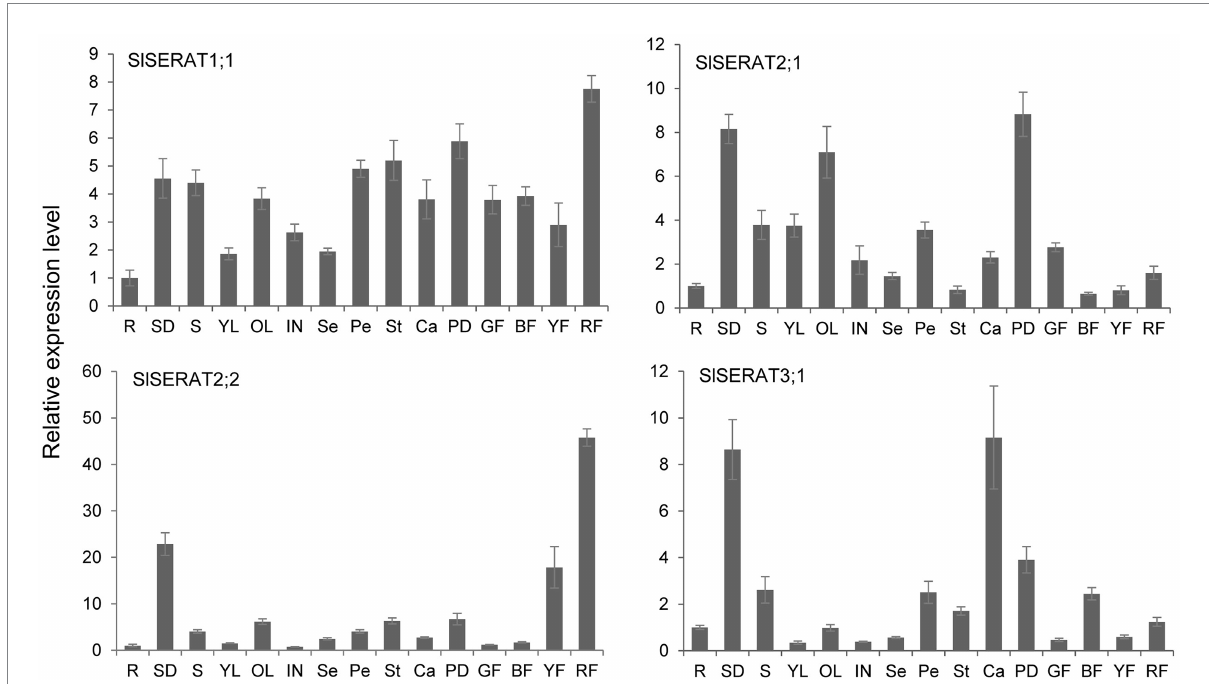
FIGURE 5 Expression pattern analyses of the SlSERAT genes during plant development. RF, red fruit; YF, yellow fruit; BF, breaker fruit; GF, immature green fruit; PD, pedicel; Ca, carpel; St, stamen; Pe, petal; Se, sepal; In, inflorescence; OL, old leaves; YL, young leaves; S, stem; SD, seedling; and R, root. The relative expression levels are fold-change values compared with root. The SAND gene was used as an endogenous